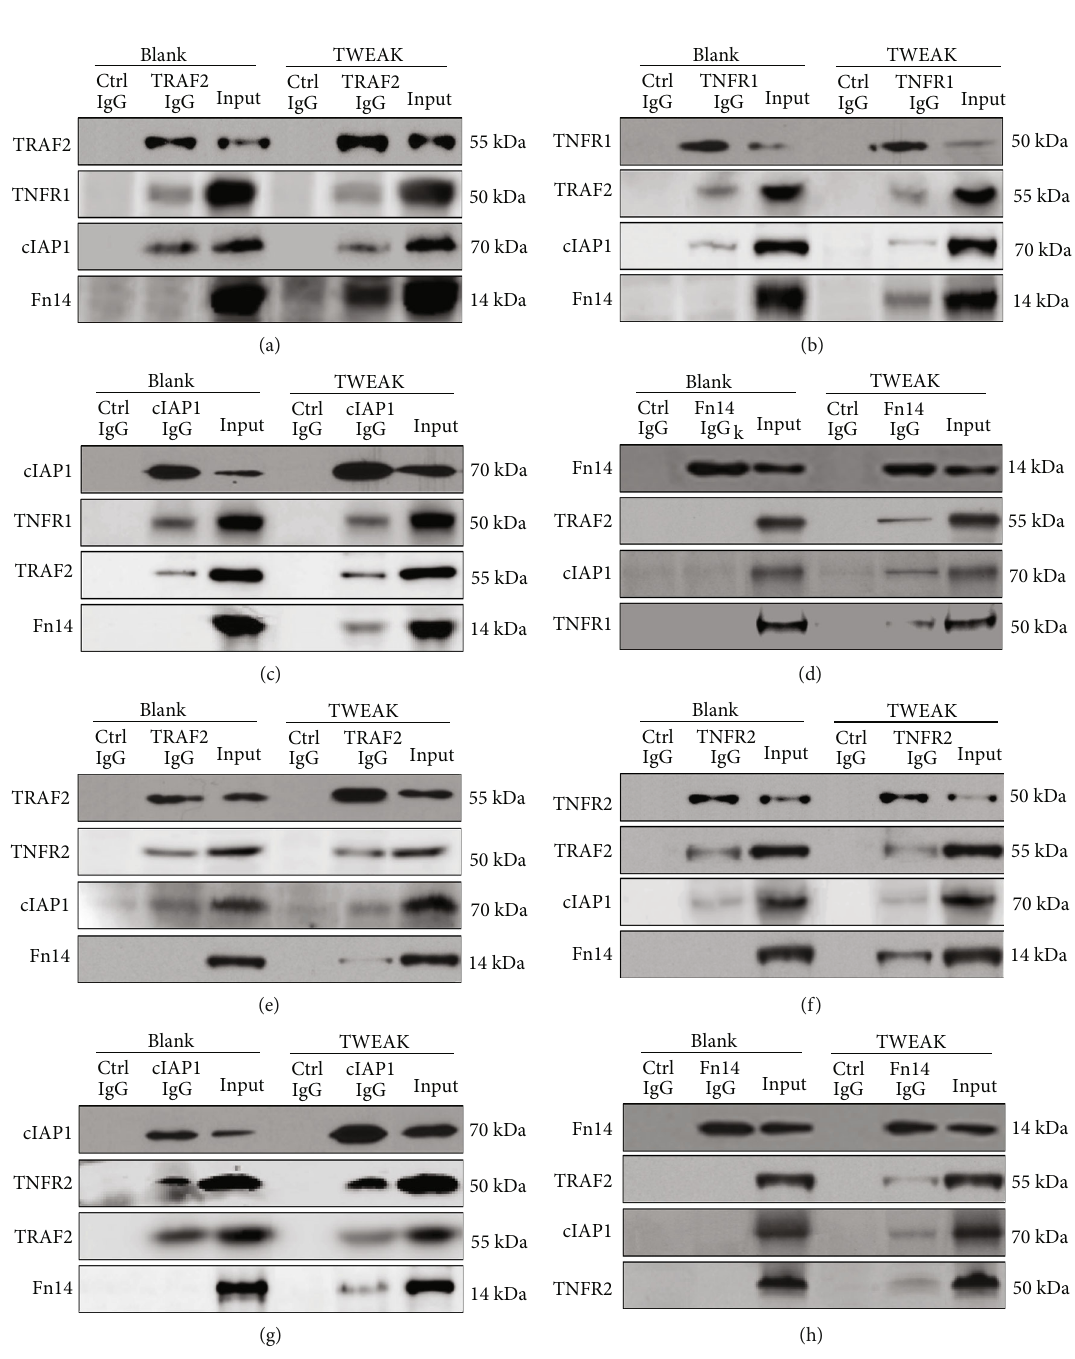
Figure 1: Detection of Fn14/TRAF2/cIAP1/TNFR complex in keratinocytes. Human primary keratinocytes were cultured in vitro , followed by extraction of protein lysates. Some cells were pretreated with TWEAK (100ng/ml, 24h). Using immunoprecipitation and Western blotting, we detected associations between the di ff erent potential binding partners. Proteins were precipitated by anti-TRAF2 (a), TNFR1 (b), cIAP1 (c), or Fn14 (d) IgG and then detected by other antibodies. Similarly, proteins were extracted from TNFR2-overexpressing keratinocytes and precipitated with anti-TRAF2 (e), TNFR2 (f), cIAP1 (g), or Fn14 (h) IgG. Input refers to the cell lysate that was aspirated before the addition of immunoprecipitation IgG. In contrast, control IgG refers to an antibody that is not related to the target protein. Data were obtained from fi ve independent experiments, and none of the blots was stripped and reprobed. Representative images are